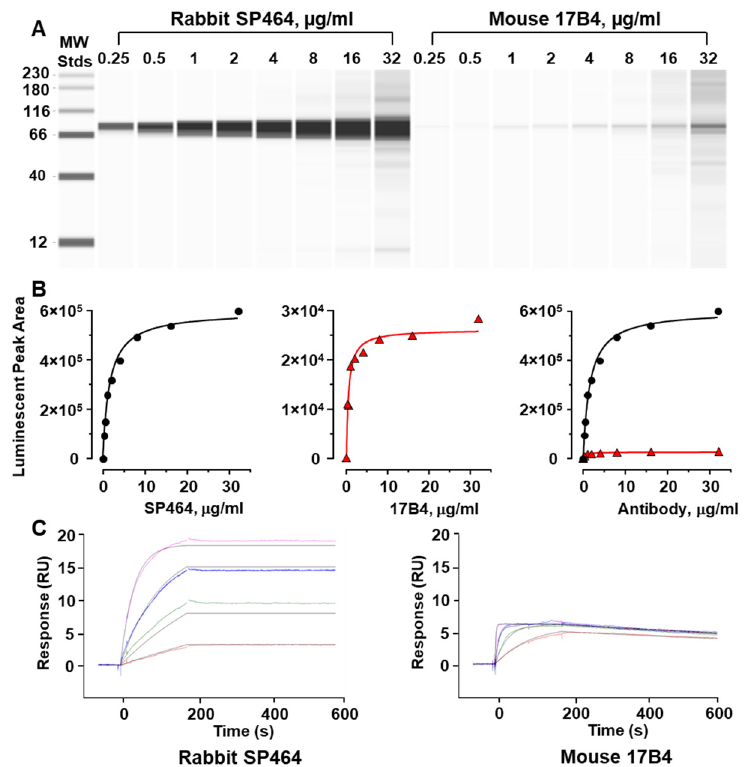
Figure 2. Binding characteristics of rabbit SP464 and mouse 17B4 monoclonal antibodies. ( A ) Increasing concentrations of antibody were applied to the HH cell line lysate in an ACE assay. ( B ) Curves were generated from the quantitation of luminescent signal peak areas versus antibody concentration for the rabbit SP464 (black circles) and the mouse 17B4 (red triangles). Comparison of the clones using the same y-axis is shown on the right. ( C ) Antibody binding kinetics using SPR analysis was done for SP464 (left) and 17B4 (right) using increasing concentrations of the full-length (30-mer) immunogen. Different concentrations are displayed in colors, while the global curve fits are displayed with black lines. Both plots have the same axes for time scale and response units.